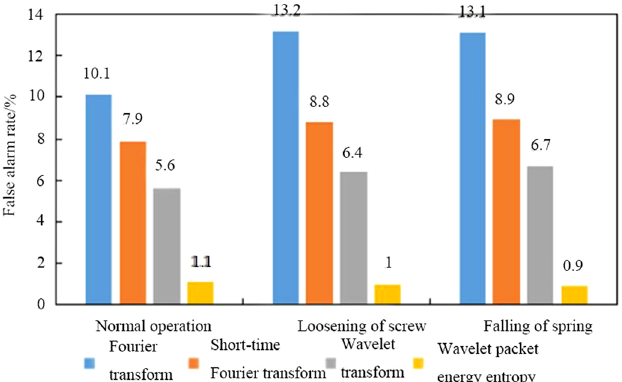
Fig. 8. Recognition false alarm rate of the fault detection model based on different feature extraction